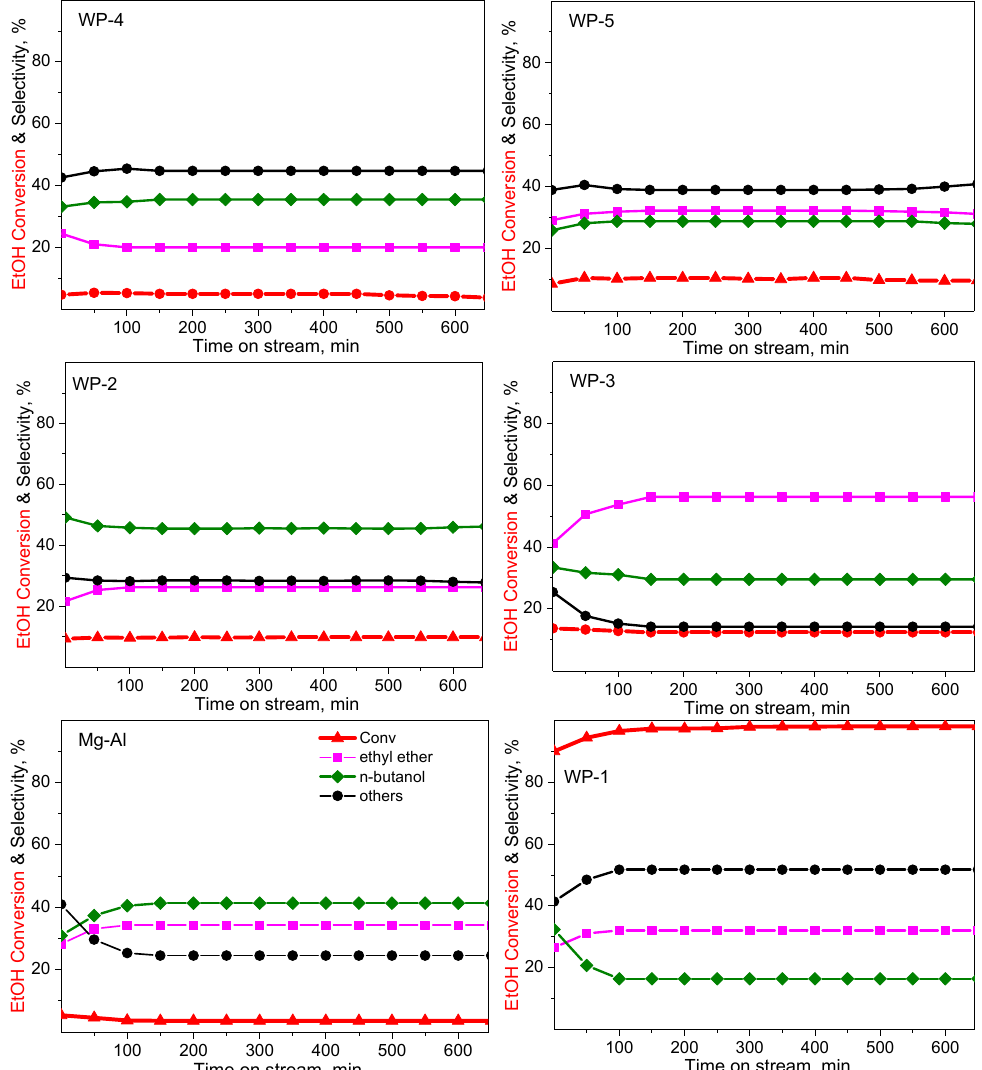
Figure 5. Ethanol conversion and stability of catalysts. Conversion and selectivity were obtained at 100 min; reaction conditions: 250 °C, 0.1 MPa in steady state. (Other products include acetaldehyde, ethyl acetate, butanal, butyl acetate, ethyl butyrate, hexanal, n-hexanol, ethyl 2-ethyl butyrate, butyl butyrate, ethyl caproate, etc., and also CO/CO 2 (if any).)